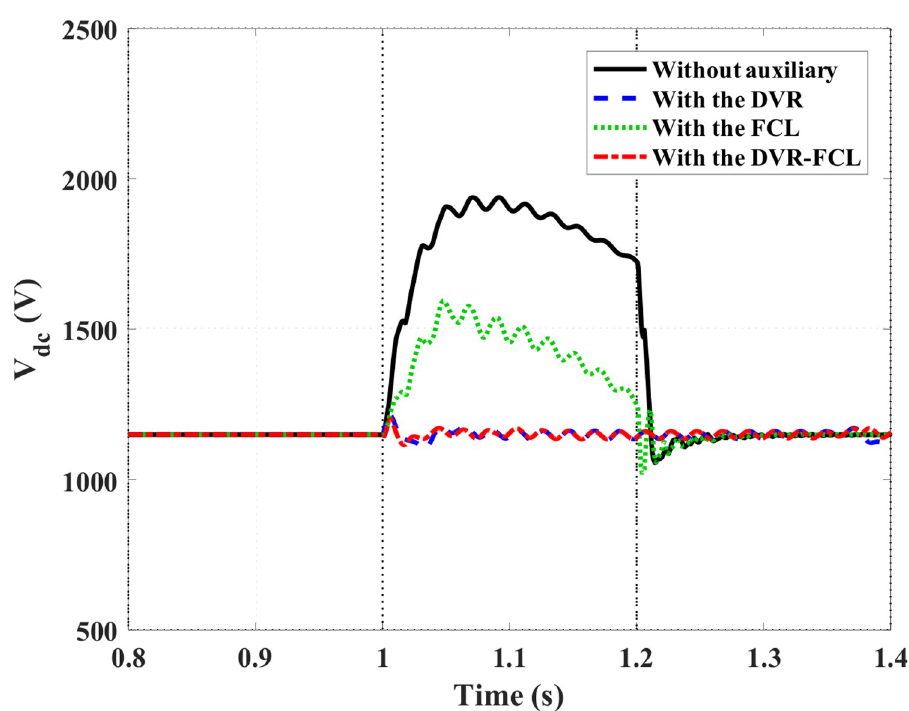
Fig 12. DC-link voltage of the DFIG subject to the symmetrical fault.